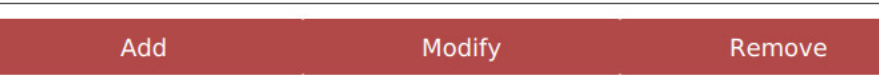
Figure 9. The expression